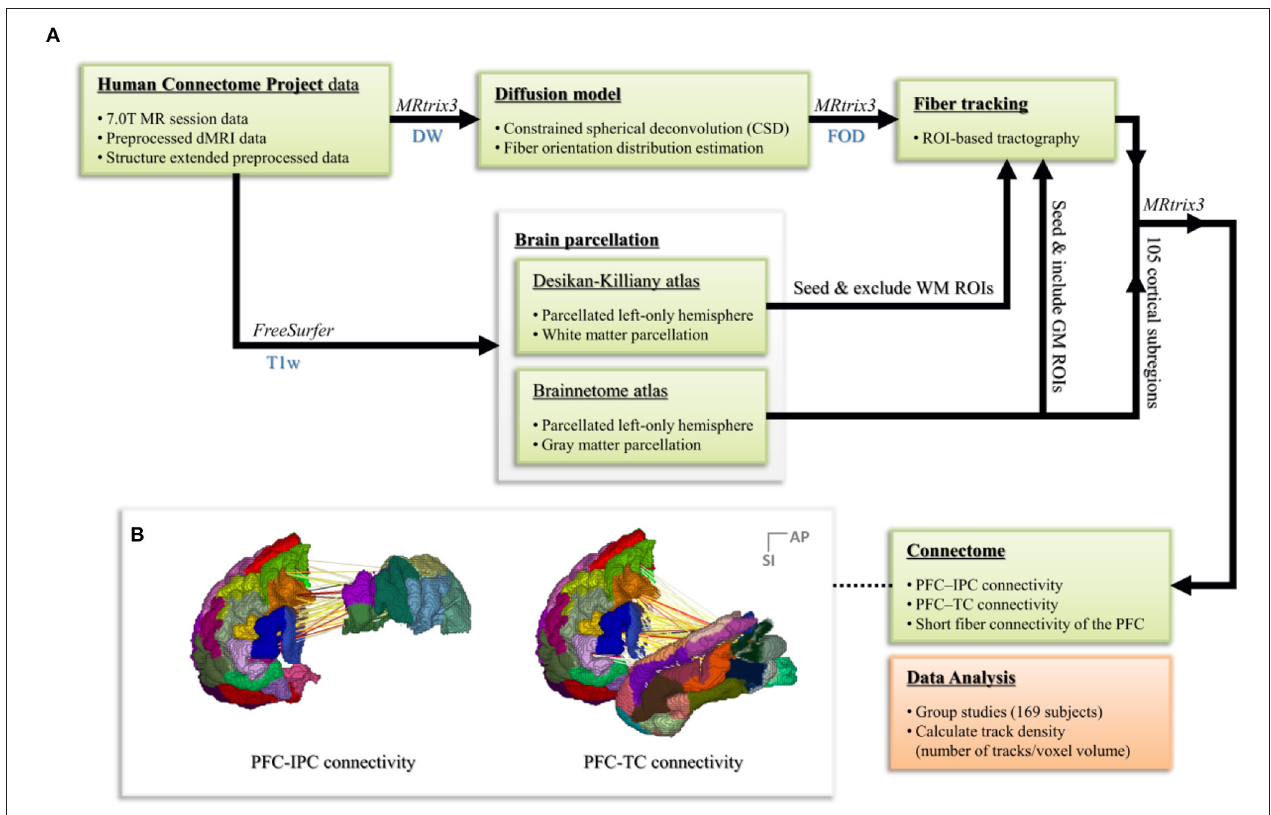
FIGURE 2 | (A) The workflow of the whole data processing steps. (B) Connectome process based on the parcellated Brainnetome atlas node for regions of